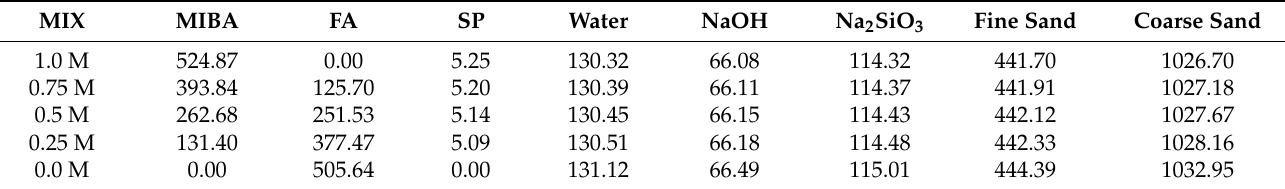
Table 2. Composition of alkali activated mortars with CAA (g/dm 3